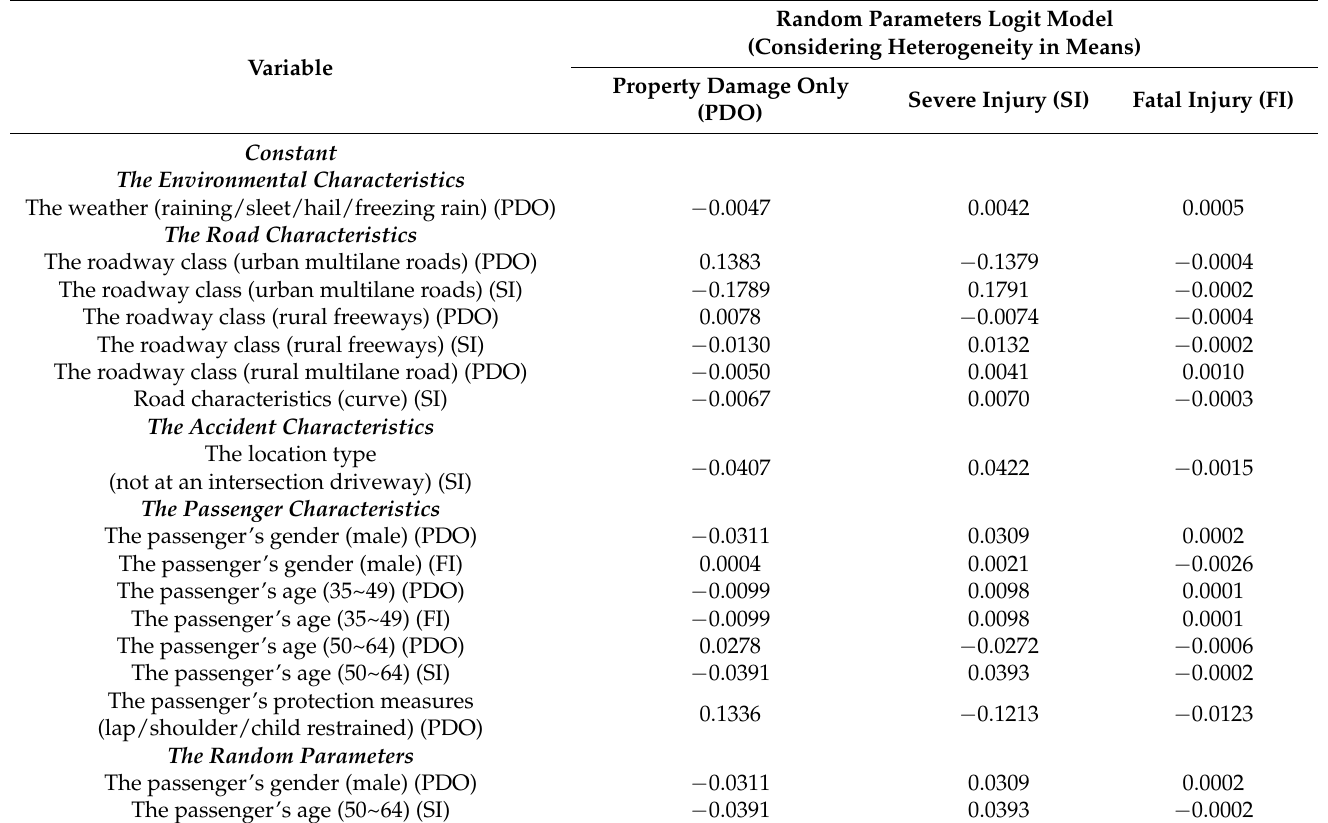
Table 4. The marginal effects of 2016 in daylight